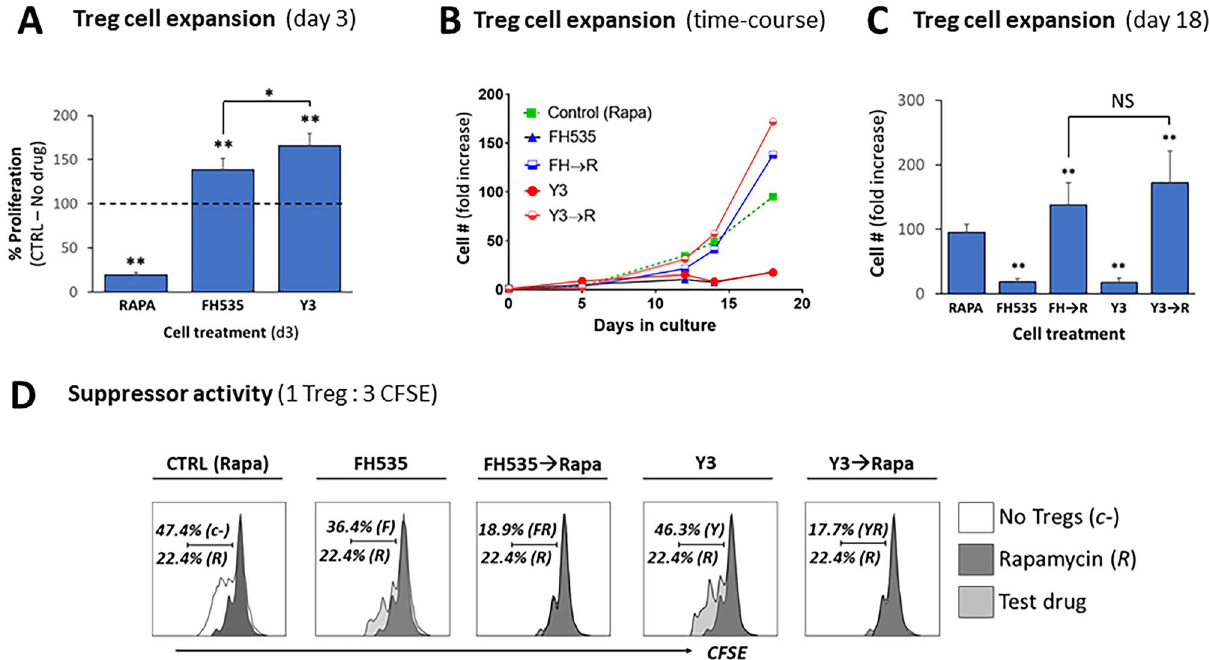
Figure 6. FH535 effects on Treg cells are replicated by the N -arylbenzene-sulfonamide derivative Y3. ( A ) Short-time effect of Y3 on Treg cell expansion. In vitro expansion of Treg cells exposed to vehicle control (no drug), Rapa, FH535 or Y3 for 3 days. Results are pooled data collected from four independent experiments and depicted as mean ± SD of percentage of experimental values with respect to control (no drug) cells (dotted line, 100% reference value). ( B ) Representative time-course experiment of in vitro expansion of Treg cells placed in culture in Treg cell media supplemented with the corresponding drug treatment. Results show the relative fold increase of cell numbers with respect to the original sample (day 0). Dotted line shows the response of the cells to the standard culture conditions with Rapa. ( C ) Comparative fold increase of Treg cell numbers generated from pooled results of four different donors are shown as mean ± SD. ( D ) The suppressor activity of Treg cells after 7 day-exposure to drug treatments was evaluated in 4-day MLR assays. Representative panels show the corresponding histograms of 1:3 ratio of Treg: CFSE-labeled T cells overlaid to standard treatment with Rapa (R, dark profile) or to the absence of Tregs (empty profile). Results show the percentages of proliferating responder cells for each condition. Individual experiments were confirmed at least three times. Data was analyzed by ANOVA with Dunnett’s test or Student’s t test for pairwise comparisons. Significance with respect to control is shown by *( ρ < 0.05) and **( ρ < 0.005); NS no significant